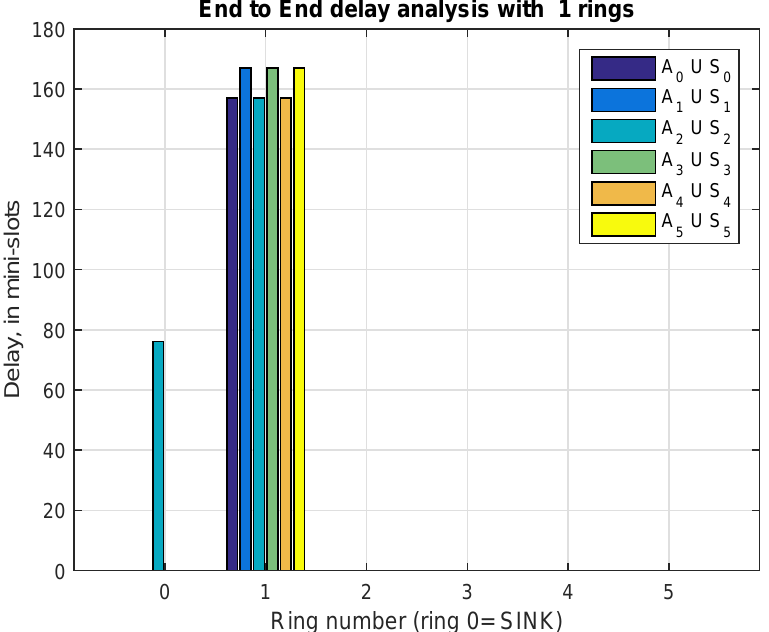
Figure 7. End to end delay (in mini-slots), from sensor to the sink, for r max = 1, p act = 0.001 and ( N ) = ( 10,3;3,7 ) msC , N intra ; N msT , N inter